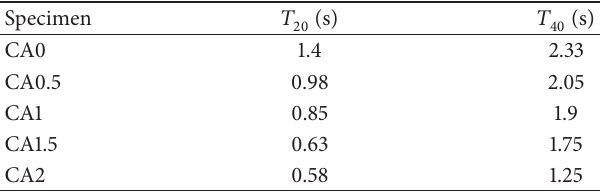
Table 6: Results of L-box test.